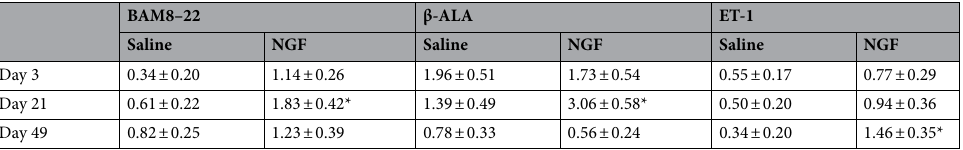
Table 1. rhNGF enhances pain during injections of BAM8–22, β-ALA and ET-1. Maximum pain recorded on a numeric rating scale (NRS, 0–10) in response to injections of BAM8–22, β-ALA, and ET-1 at 3 days (n = 11), 21 days (n = 9) and 49 days (n = 11; n = 8 for β-ALA) post rhNGF and saline administration, respectively. Values are given as mean ± standard error (SEM), asterisks indicate significant differences between rhNGF and saline (p <